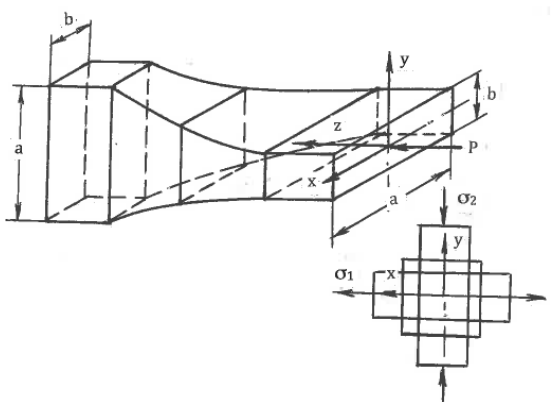
Figure 22. Equal channel forward extrusion. Materials 2018 , 11 , x FOR PEER REVIEW